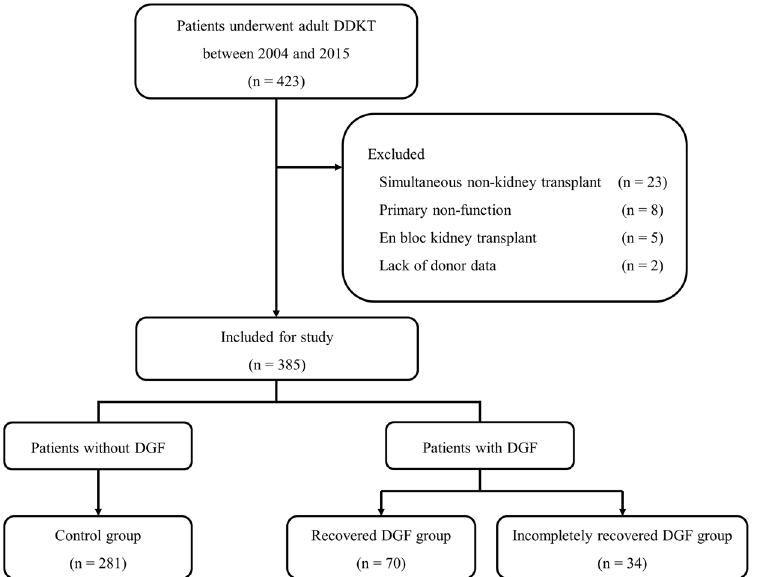
Figure 1. Study flow